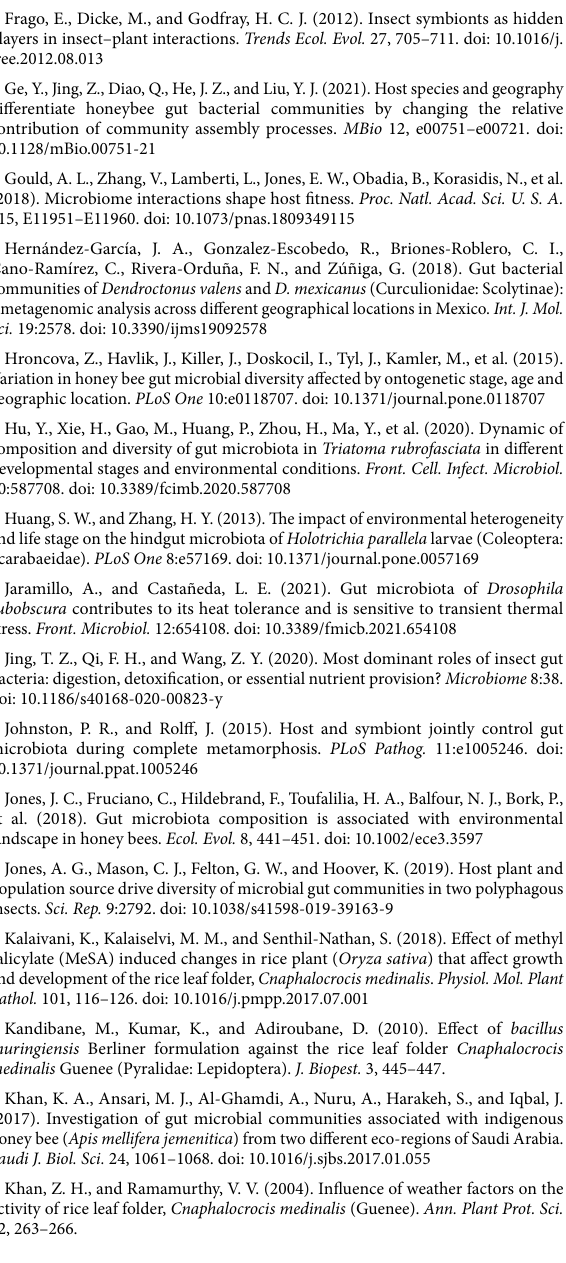
SUPPLEMENTARY FIGURE S1 Rarefaction curves of the bacterial community of Cnaphalocrocis medinalis from different geographic sources based on Illumina MiSeq sequencing